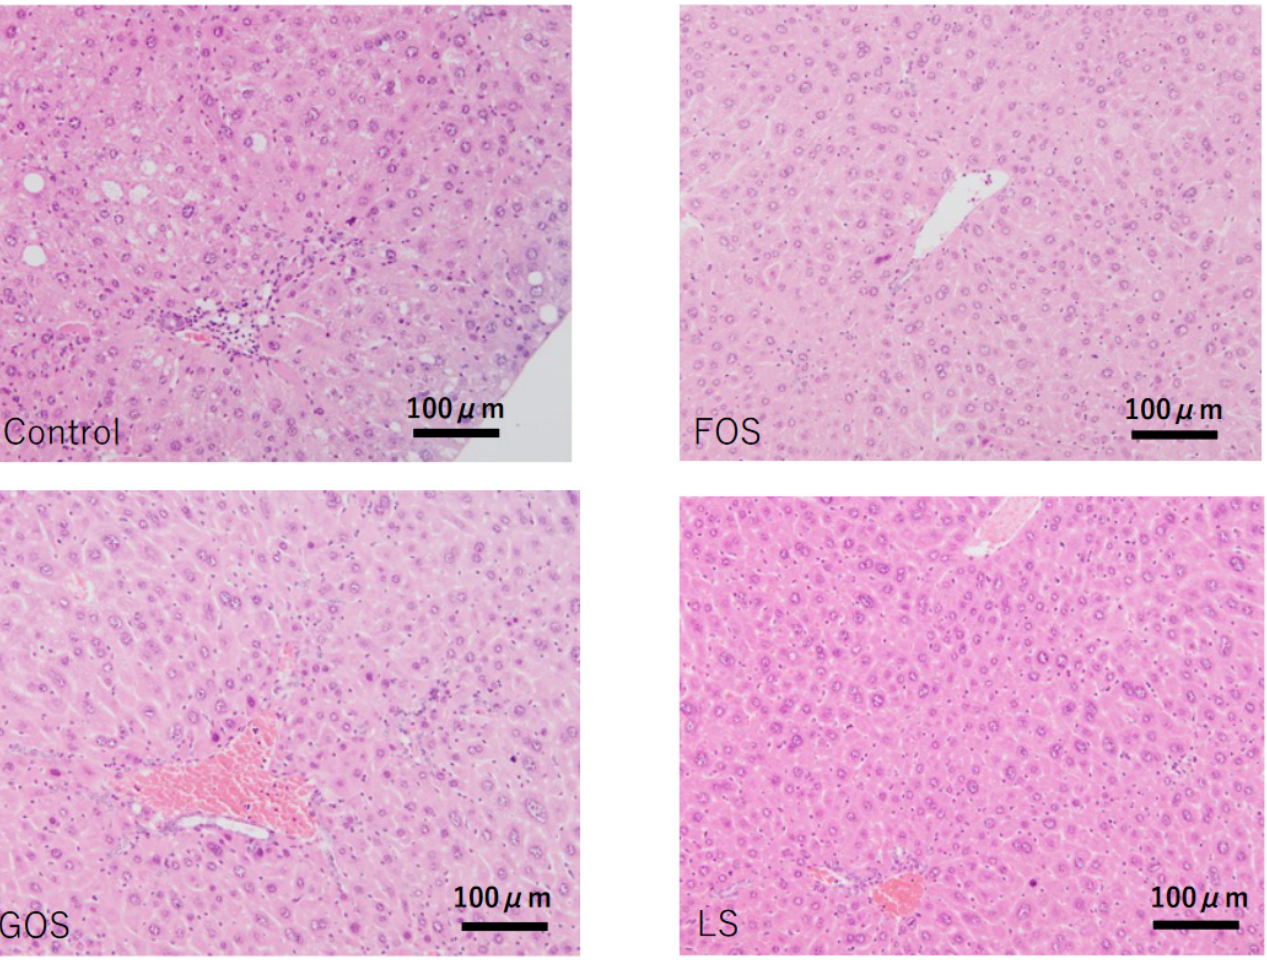
Figure 6. Characteristic pathological features of the liver in each group. Control: mild fatty changes as well as mild necro-inflammatory changes were observed. FOS, GOS, LS: no significant changes, including steatosis, were observed. (HE staining, scale bar: 100 μ m).